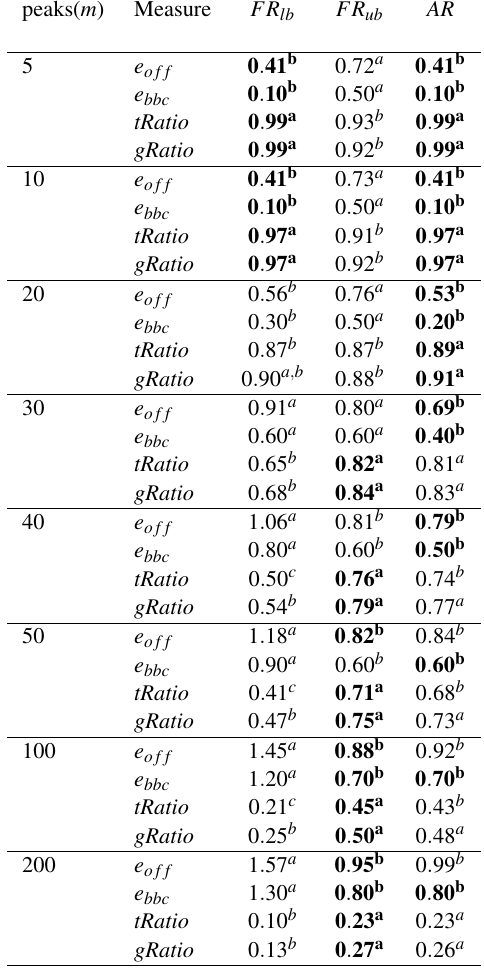
Table 6. e of f , e bbc , tRatio and gRatio obtained by FR lb , FR ub and AR over 8 MPB configuration with different number of peaks ( peaks = { 5 , 10 , 20 , 30 , 40 , 50 , 100 , 200 } ) when the mech- anism to adjust the resolution parameter δ min is activated and not. The superscripts of the values provide the same informa- tion as explained in Table